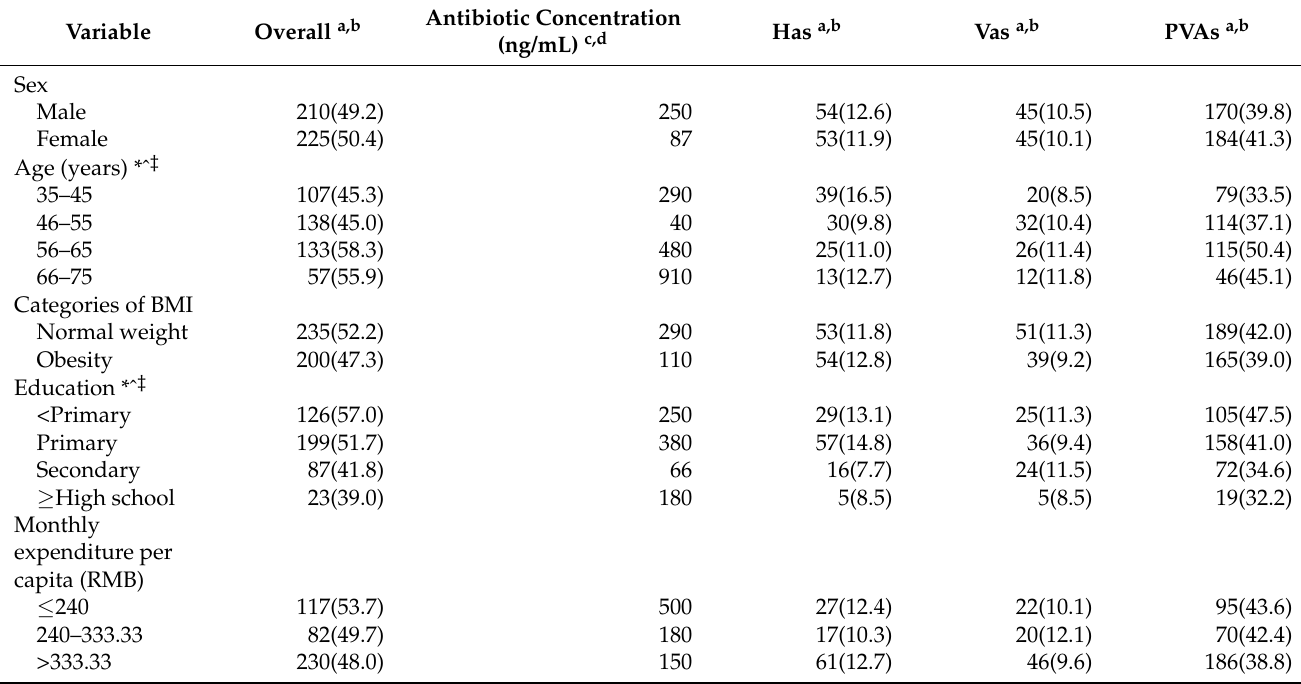
Table 2. Overall Detection Rate and Concentrations of Urinary Antibiotics in Relation to Selected